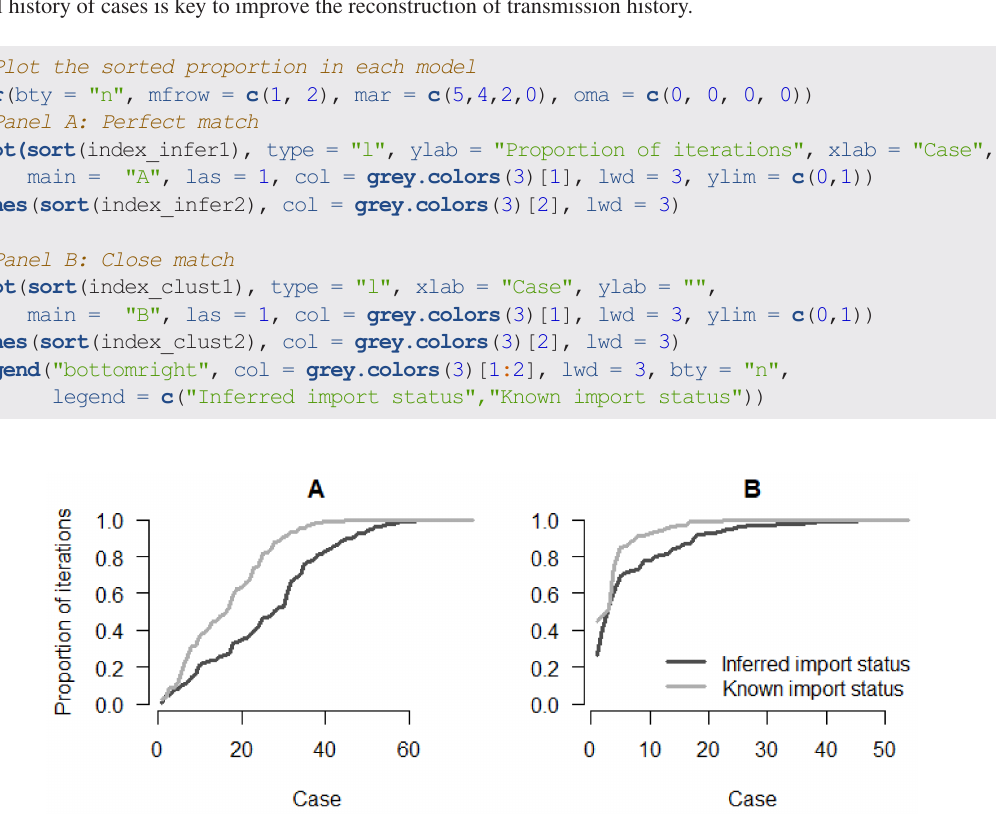
Figure 4. Panel A : Proportion of iterations with the correct index for each case; Panel B : Proportion of iterations where the index is from the correct